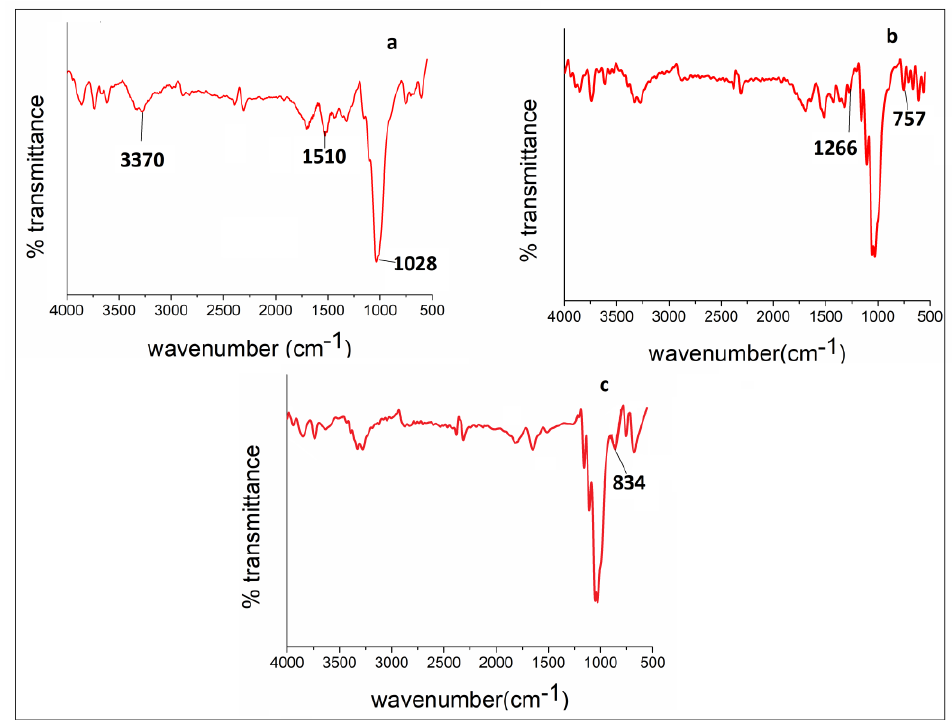
Figure 1. FT-IR of ( a ) Cellulose, ( b ) CSn, and ( c ) CSn with adsorbed As(III). The observed X-ray diffraction (XRD) patterns of cellulose and CSn are shown in Figure 2. Cellulose biopolymer shows diffraction peaks at 2 θ = 14.88 ◦ and 22.26 ◦ [11]. In CSn, three new peaks at 2 θ = 27.1 ◦ , 34.5 ◦ , and 51.44 ◦ have been observed, which matched with the reported peaks of Sn(IV) and confirmed the incorporation of Sn(IV) into the cellulose matrix [20]. Low intensity and broadened peaks are characteristics of amorphous behavior. The decrease in crystallinity of adsorbent can be attributed to the typical amorphous regions of cellulose which are introduced through intramolecular and intermolecular H-bonding interactions and rearrangement